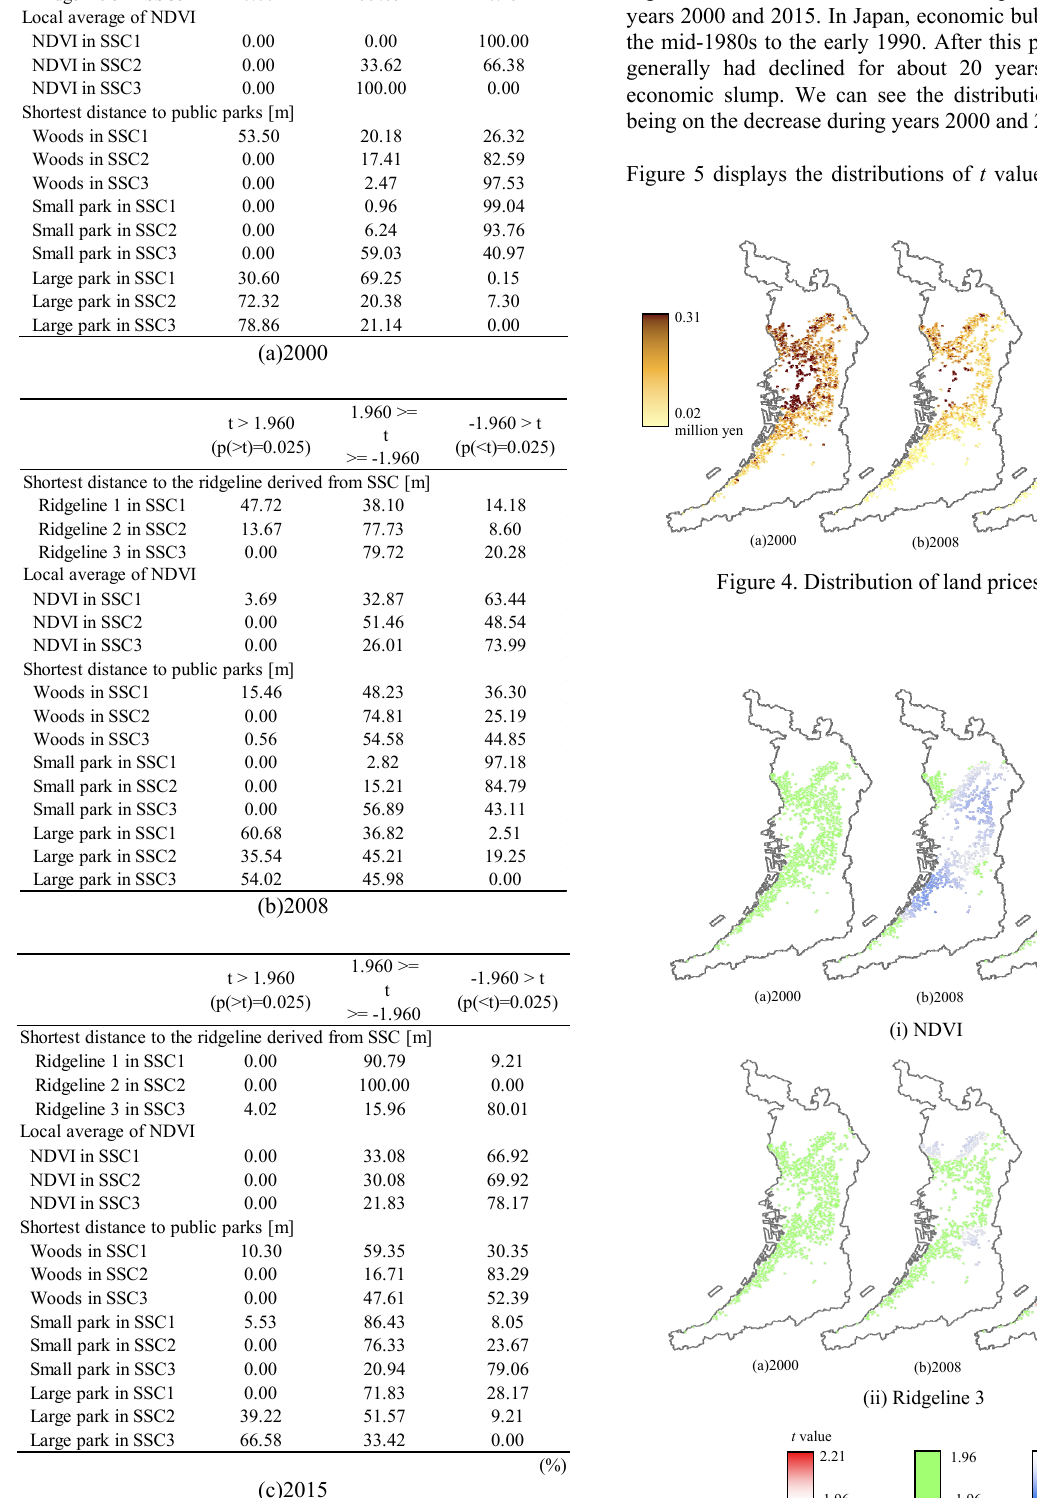
Table 4. Proportions of t values of the variable in landscape factors are indicated on the basis of the significance level of 5%